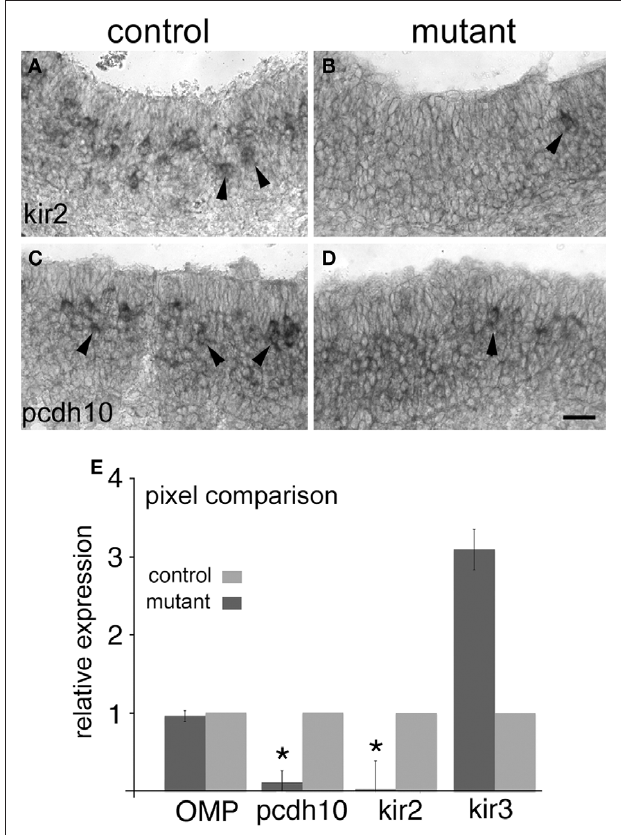
Figure 7 | Pcdh10 is reduced in expression in CNGA2 mutants. (A) Expression of kirrel2 in epithelia (arrowheads) of control CNGA2 + / + littermate at E16.5. (B) Expression of kirrel2 in a CNGA2 − / − mutant animal (arrowhead) is reduced relative to control. (C) Expression of pcdh10 in control littermate at E16.5. (D) Expression of pcdh10 in a CNGA2 − / − mutant. (e) Pixel intensity comparison between epithelia derived from mutant and control animals. Data from three mutant/control pairs (E16.5) were examined for differences in signal intensity. OMP showed no significant difference in expression between mutants and controls ( p = 0.69). Pcdh10 expression in CNGA2 mutants was 10% that of control ( p < 0.05) while kirrel2 expression was just 2% of control ( p < 0.05). Kirrel3 expression was approximately three times that of control, but this difference was not significant ( p = 0.31). Scale bar = 50 μm.